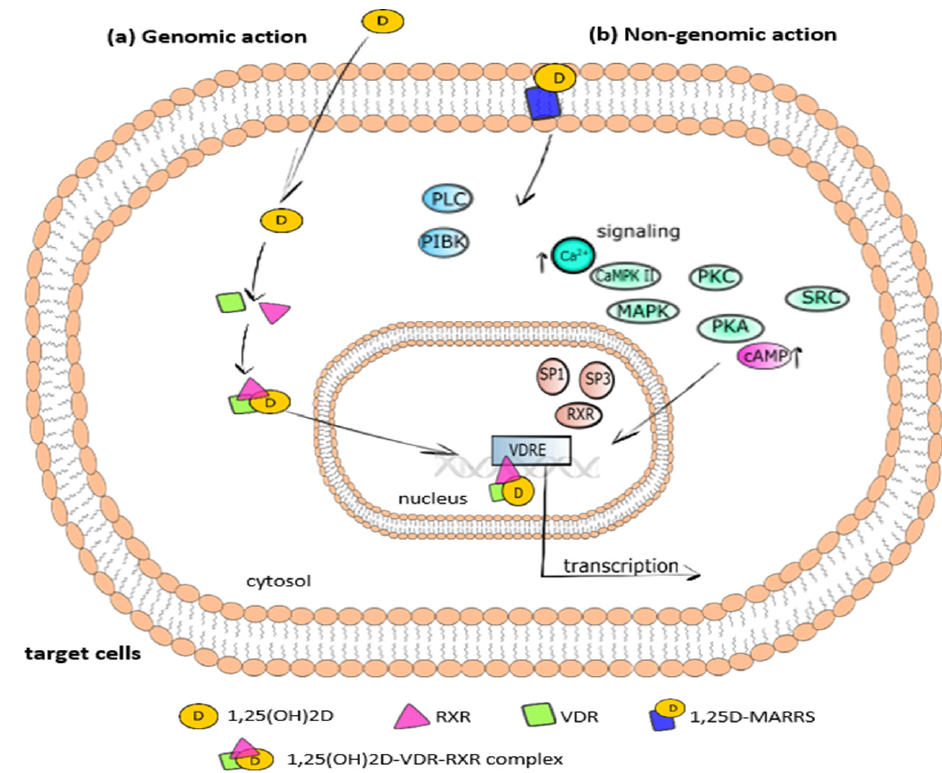
Figure 2. Summary of the cellular responses to vitamin D identified so far: ( a ) genomic and ( b ) non-genomic pathways. Active metabolites of vitamin D are characterized by a broad and diverse biological activity. In many tissues and cells, vitamin D binds to the nuclear vitamin D receptor (VDR) and then forms a heterodimer with the 9-cis retinoic acid receptor (RXR) with the properties of a transcription factor, which initiates ( a ) genomic action of the molecule. The nongenomic effects ( b ) are mediated by a membrane-located cellular receptor, which is distinct from the nuclear receptor and triggers intracellular metabolic pathways modulating the effects of gene expression. Abbreviations: D, 1,25(OH) 2 D; VDR, vitamin D receptor; RXR, retinoid X receptor; VDRE , vitamin D response element; 1,25D-MARRS, 1,25D-membrane-associated rapid response steroid-binding protein; PI3K, phosphatidyl-inositol-3 kinase; MAPK, mitogen-activated protein kinases; PLC, phospholipase C; CaMPKII, Ca 2+ -calmodulin protein kinase II; PKC, protein kinase C; Src, nonreceptor tyrosine kinase Src; PKA, protein kinase A; cAMP, cyclic adenosine monophosphate; SP1 and SP3, transcription factors. ↑ increase; ↓ decrease.